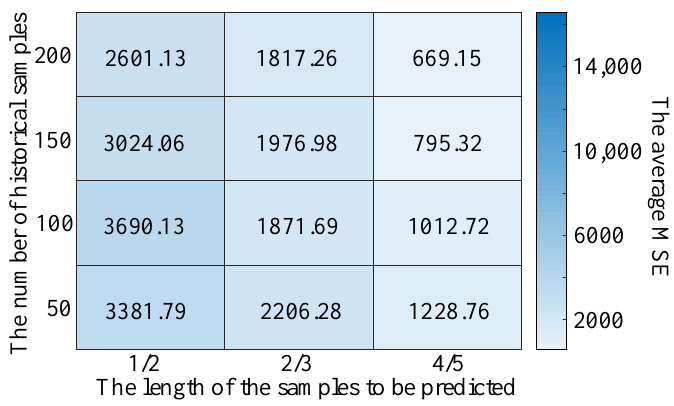
Figure 11. The average Mean Squared Error (MSE) of the proposed method.